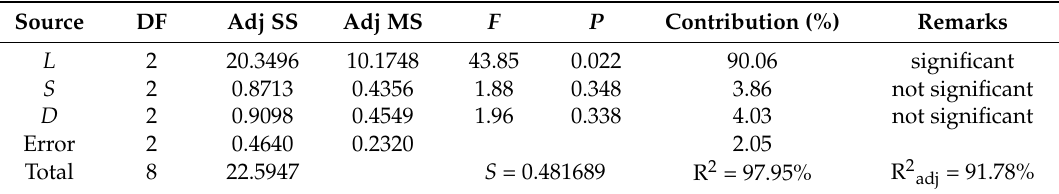
Table 7. ANOVA for S/N ratio of Ws .